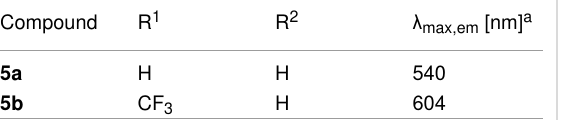
Table 6: Photophysical properties of 1 H -pyridines 5a and 5b in the solid state. Compound